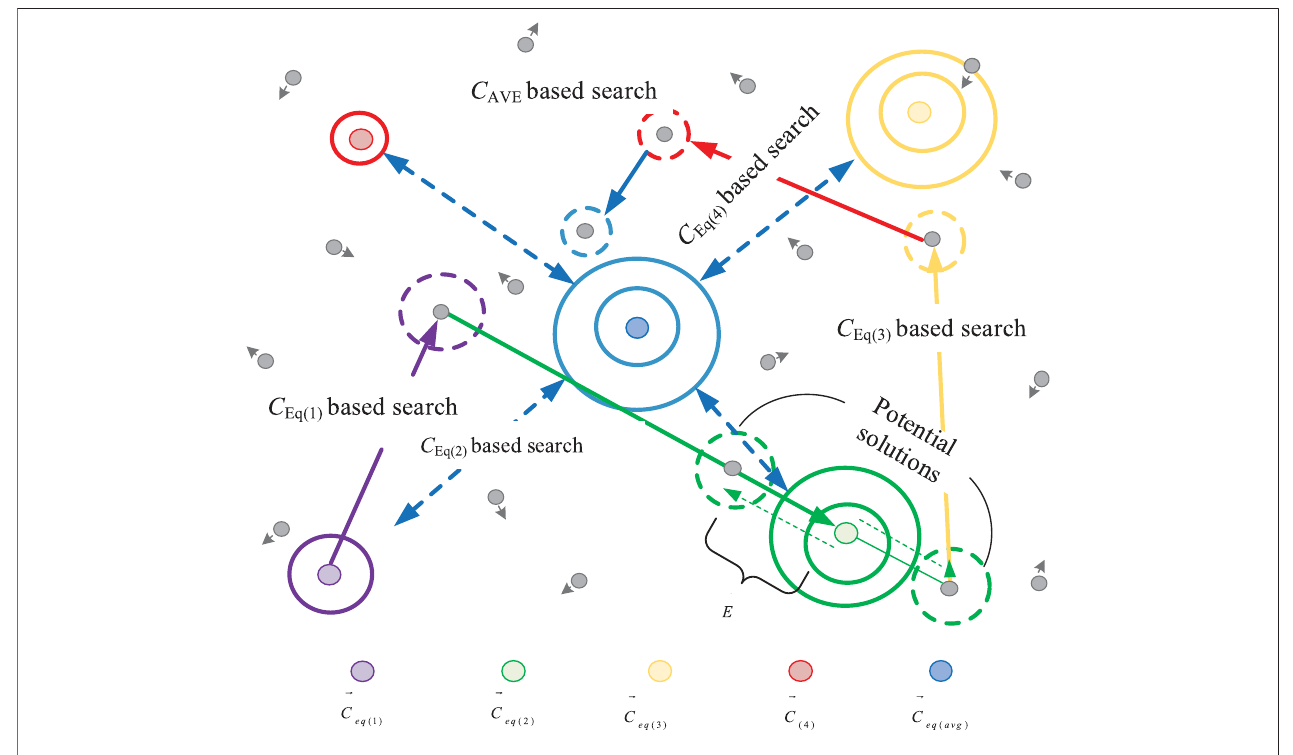
FIGURE 2 | Illustration of solutions updating principle of